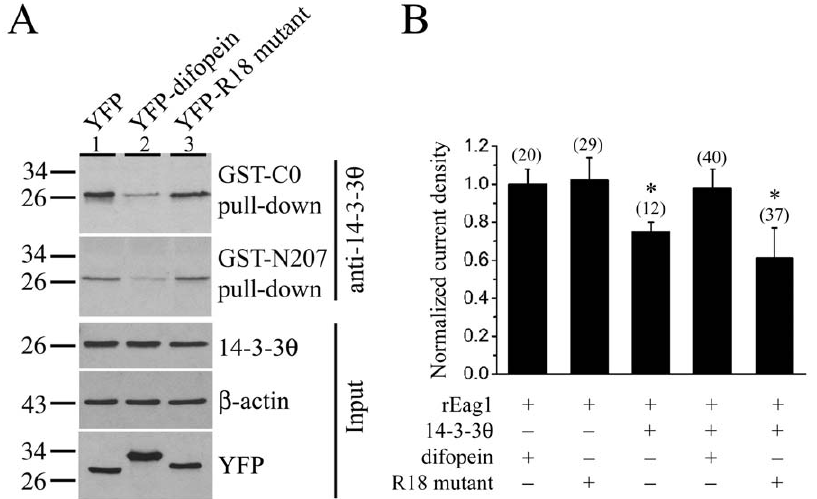
Figure 8. Reversal of the 14-3-3 h suppression of rEag1 K + currents by the 14-3-3 antagonist difopein. ( A ) GST pull-down assay of the cell lysates prepared from HEK293T cells over-expressing the YFP vector, YFP-difopein, or YFP-R18 mutant. Pull-down products were detected by immunoblotting with the anti-14-3-3 h antibody. Compared to the vector control ( lane 1 ), introduction of difopein ( lane 2 ) resulted in a 75% and 64% reduction in the amount of 14-3-3 h pull-down by the GST-C0 and GST-N207 fusion proteins, respectively. In contrast, no significant difference was observed in the presence of the inactive mutant control ( lane 3 ). ( B ) Normalized mean K + current density recorded from HEK293 cells stably expressing rEag1 channels. As indicated, these stable cell lines were subject to transient transfection with various cDNA constructs. The mean current density at + 40 mV for each co-expression condition was normalized with respect to that of the co-expression of rEag1 and difopein. The numbers in the parentheses refer to the number of cells analyzed, and the asterisk denotes significant difference from the rEag1-difopein co-expression control (*, t -test: p , 0.05).